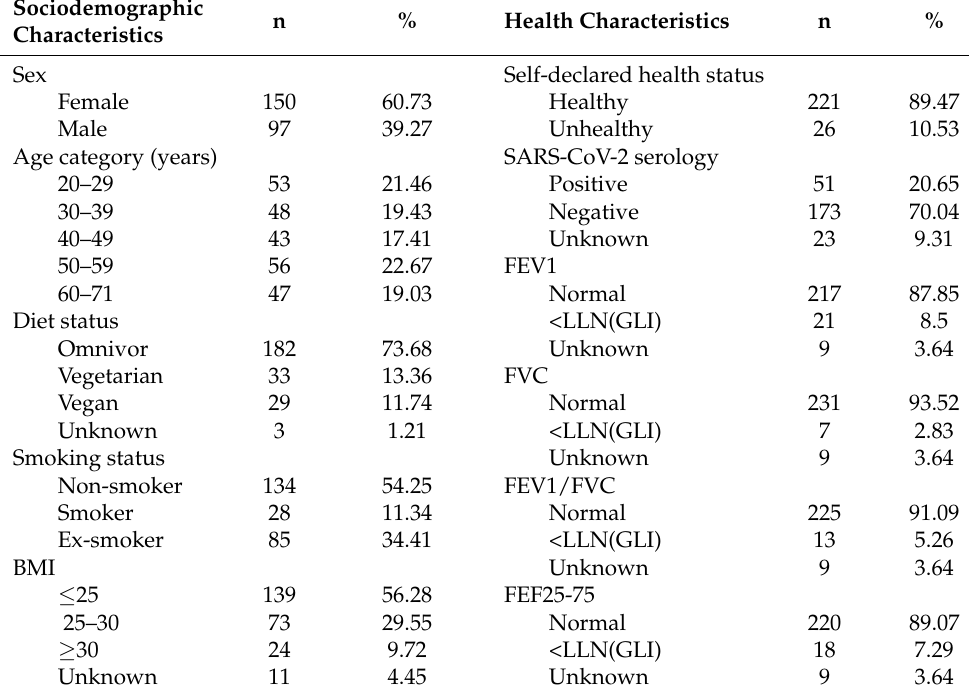
Table 1. Description of the study sample (N = 247).